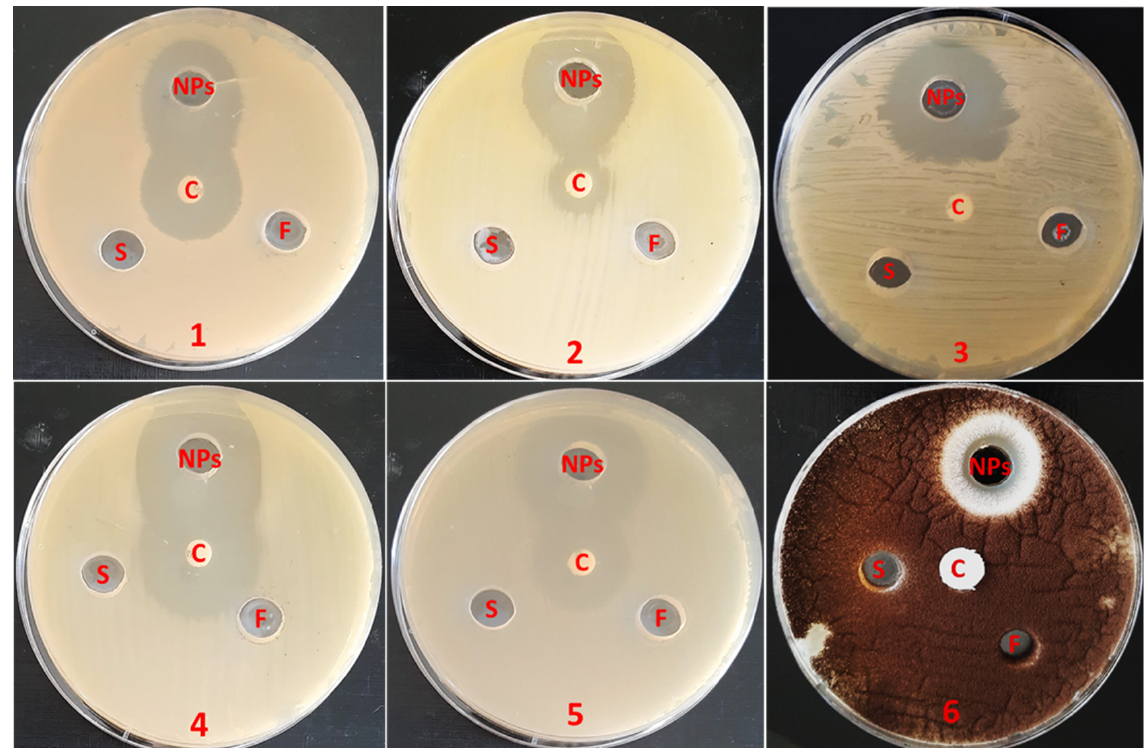
Figure 3. Antimicrobial activities of Hi- ZnO-NPs (NPs), H. impatiens aqueous extract (F), Zinc acetate solution (S), and standard antibiotics (C) against S. typhi ( 1 ); K. pneumonia ( 2 ); E. coli ( 3 ); S. aureus ( 4 ); E. faecalis ( 5 ), and A. niger , ( 6 ) using agar diffusion assay. Measurements were conducted in triplicates per each sample. Table 3. Larvicidal activity of Hi -ZnO-NPs against the 3rd larval instar of the mosquito vector, Culex pipiens